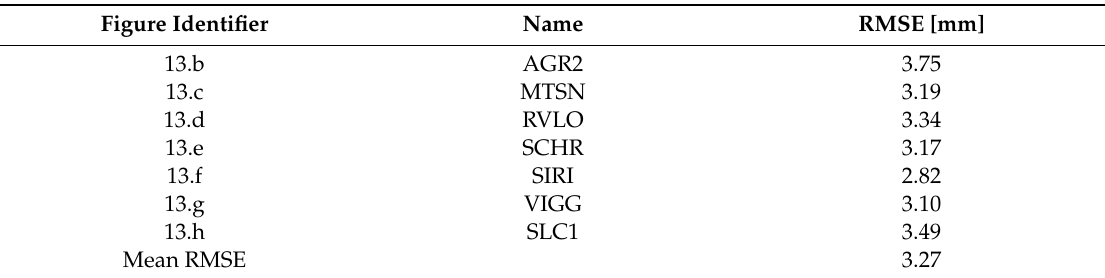
Figure 13. Comparison between the GPS measurements and the LOS-projected deformation time-series in correspondence with the seven available GPS stations of the area. ( a ) Mean displacement velocity map of the area. ( b – h ) Plots of the LOS-projected ground deformation time-series (black triangles) and the GPS deformation measurements projected along the radar sensor LOS (red crosses). Table 2. Root Mean Square Error (RMSE) of the di ff erence between SAR and GPS LOS-projected